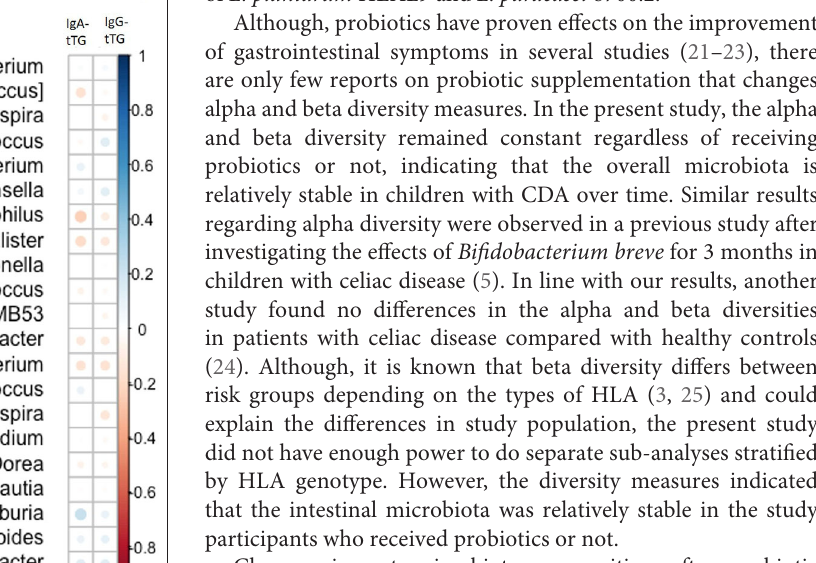
to Oscillospira and Parabacteroides increased while